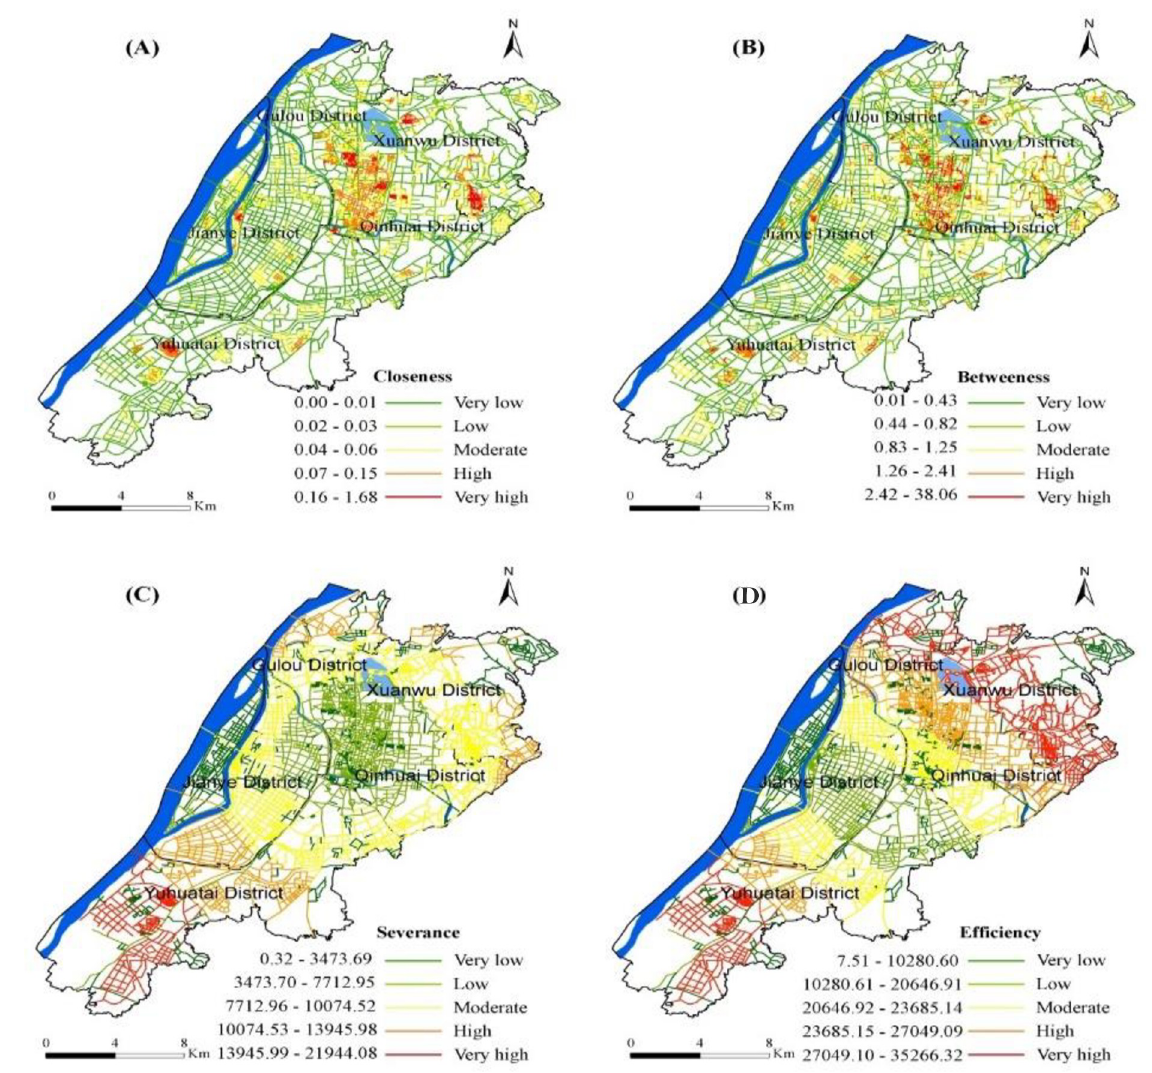
Fig 3. Spatial distribution of USN’s centralities in downtown Nanjing